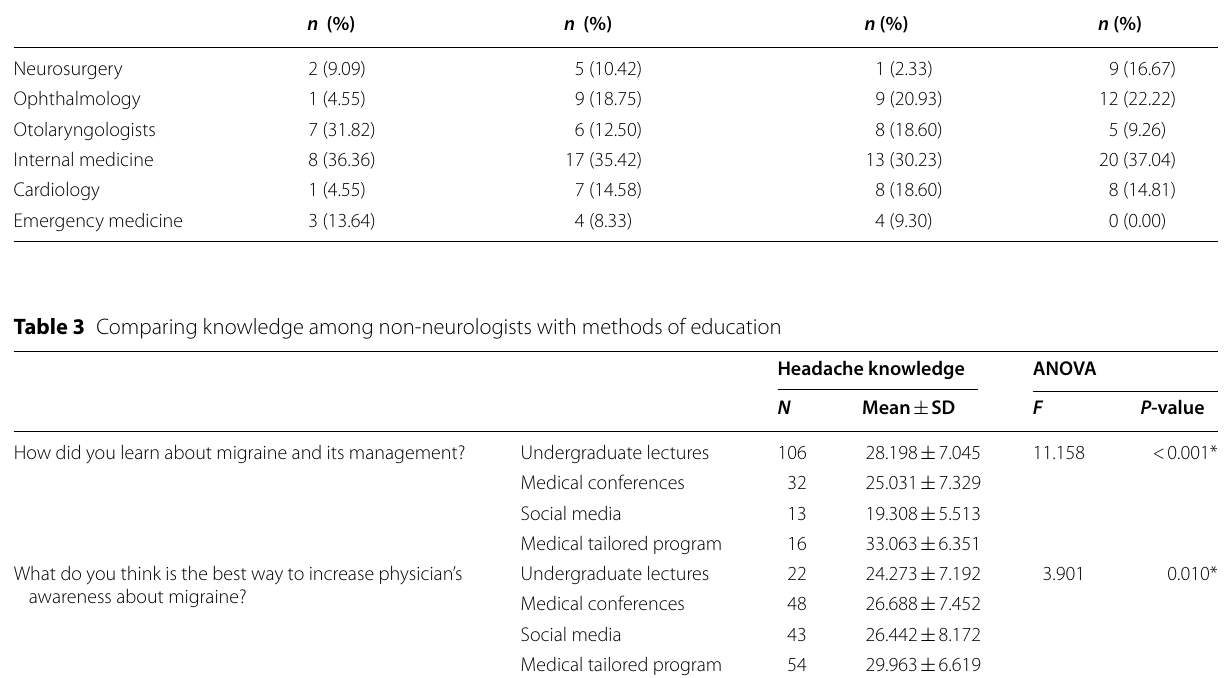
Table 2 Physician’s preference regarding increasing awareness: Specialty What do you think is the best way to increase physician’s awareness about migraine? Undergraduate lectures